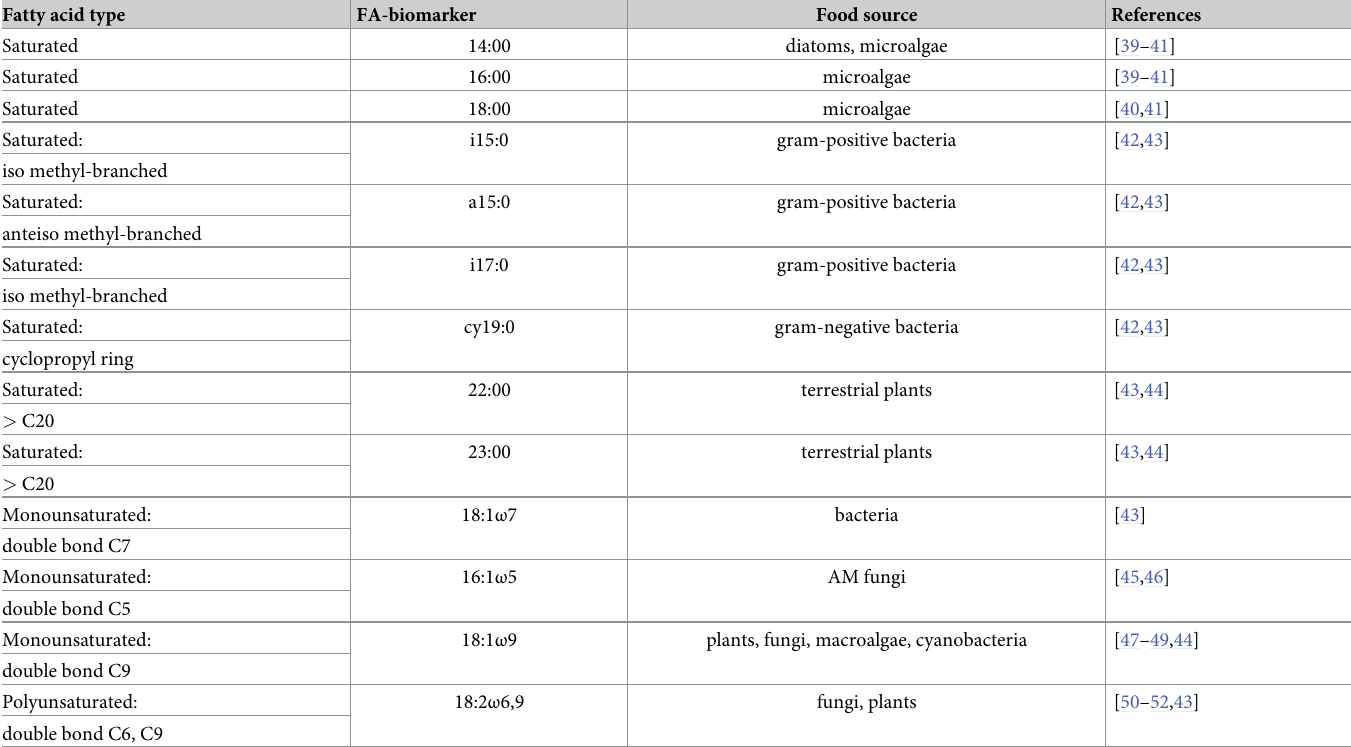
Table 1. Characteristic fatty acid biomarkers in salt marsh Oribatida based on